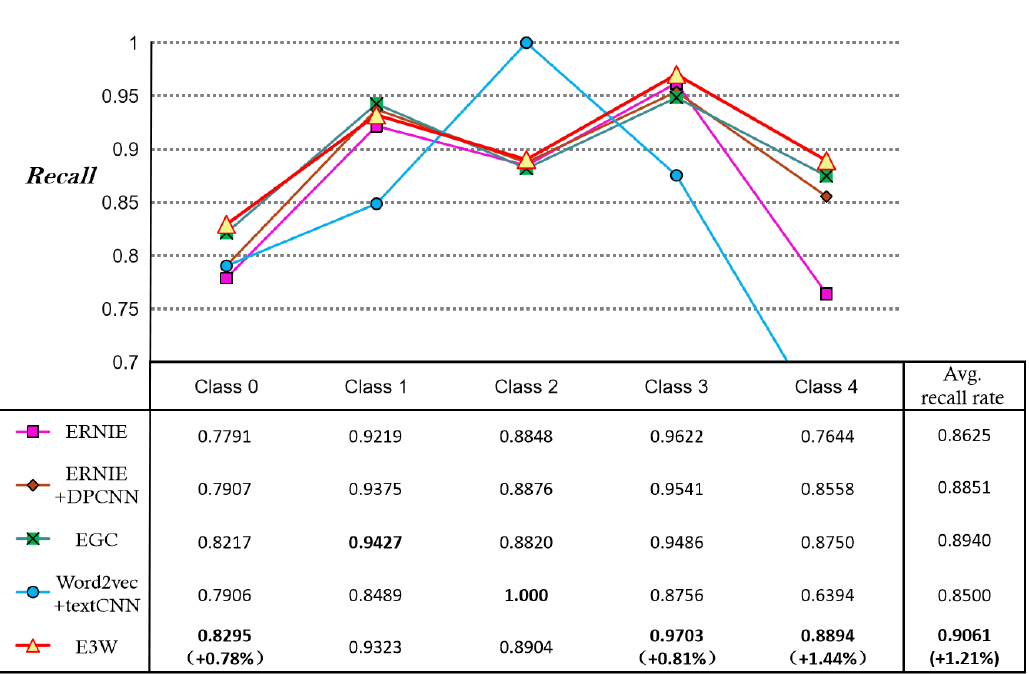
Figure 15. Comparison of recall for E3W and the four sub-models, with the best experimental results in bold and the number in brackets representing the comparison of the current model with the previous best model.